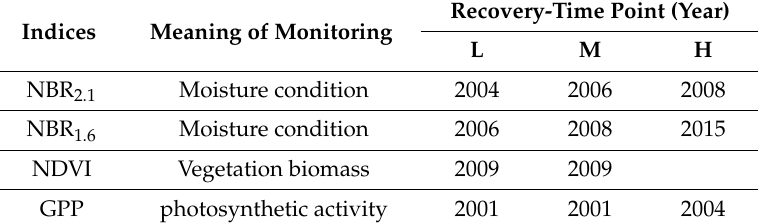
Table 3. Recovery-time point (year) indicated by four indices (i.e., NBR 2.1 , NBR 1.6 , NDVI, and GPP) in regions of three fire severity levels during 18 years. L, M, and H represent the low, moderate, and high severity burned areas,